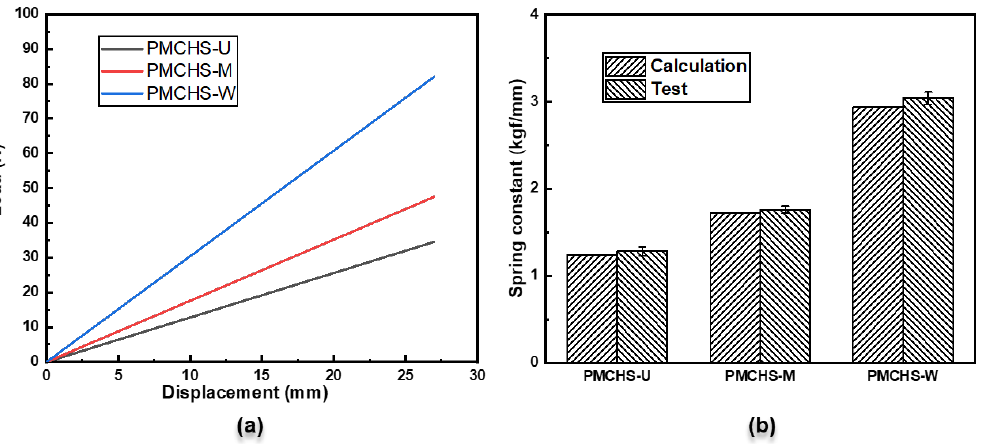
Figure 5. ( a ) Load – displacement curves of PMCHSs and ( b ) comparison of calculated and experi- mental spring constants. mental spring